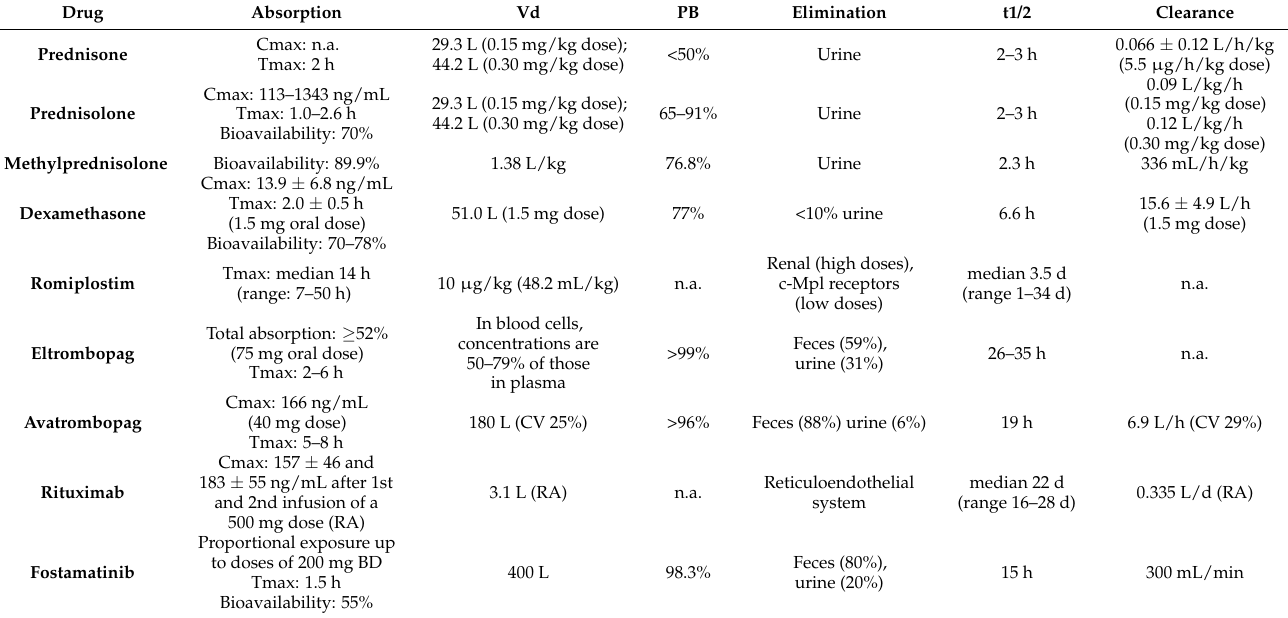
Table 1. Pharmacokinetics of the current first- and second-line drugs prescribed to treat ITP patients.